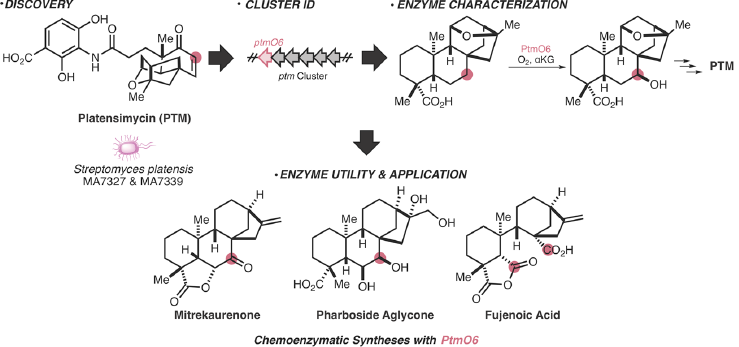
Figure 1. Workflow from natural product discovery to enzyme utility in accessing complex